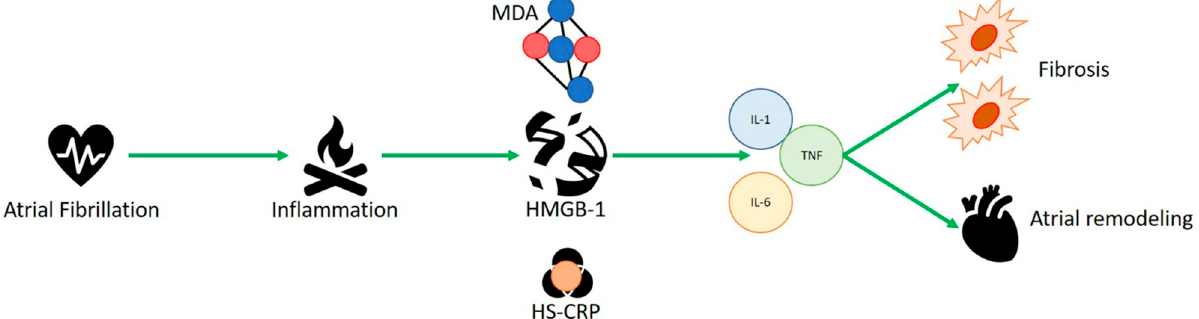
Figure 1. HMGB1 appears to be highly represented in patients with atrial fibrillation, correlating its concentration with malondialdehyde (MDA) and C-reactive protein (HS-CRP), which represents another inflammatory protein. HMBG1 could be amplifier of the inflammatory response with the recall of proinflammatory cytokines such as IL-1, tumor necrosis factor (TNF) and IL-6, which handle atrial remodeling, fibrosis and in the onset of post-surgical AF.